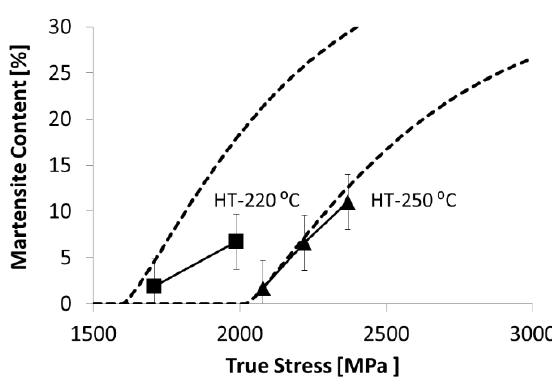
Figure 14. Experimental results (solid symbols) for the martensite content evolution as a function of the true stress of tensile test, and predicted values (dotted lines) according to the procedure mentioned in the main text, for two nanobainitic structures from one steel treated at 220 and 250 °C. Adapted from reference [73].